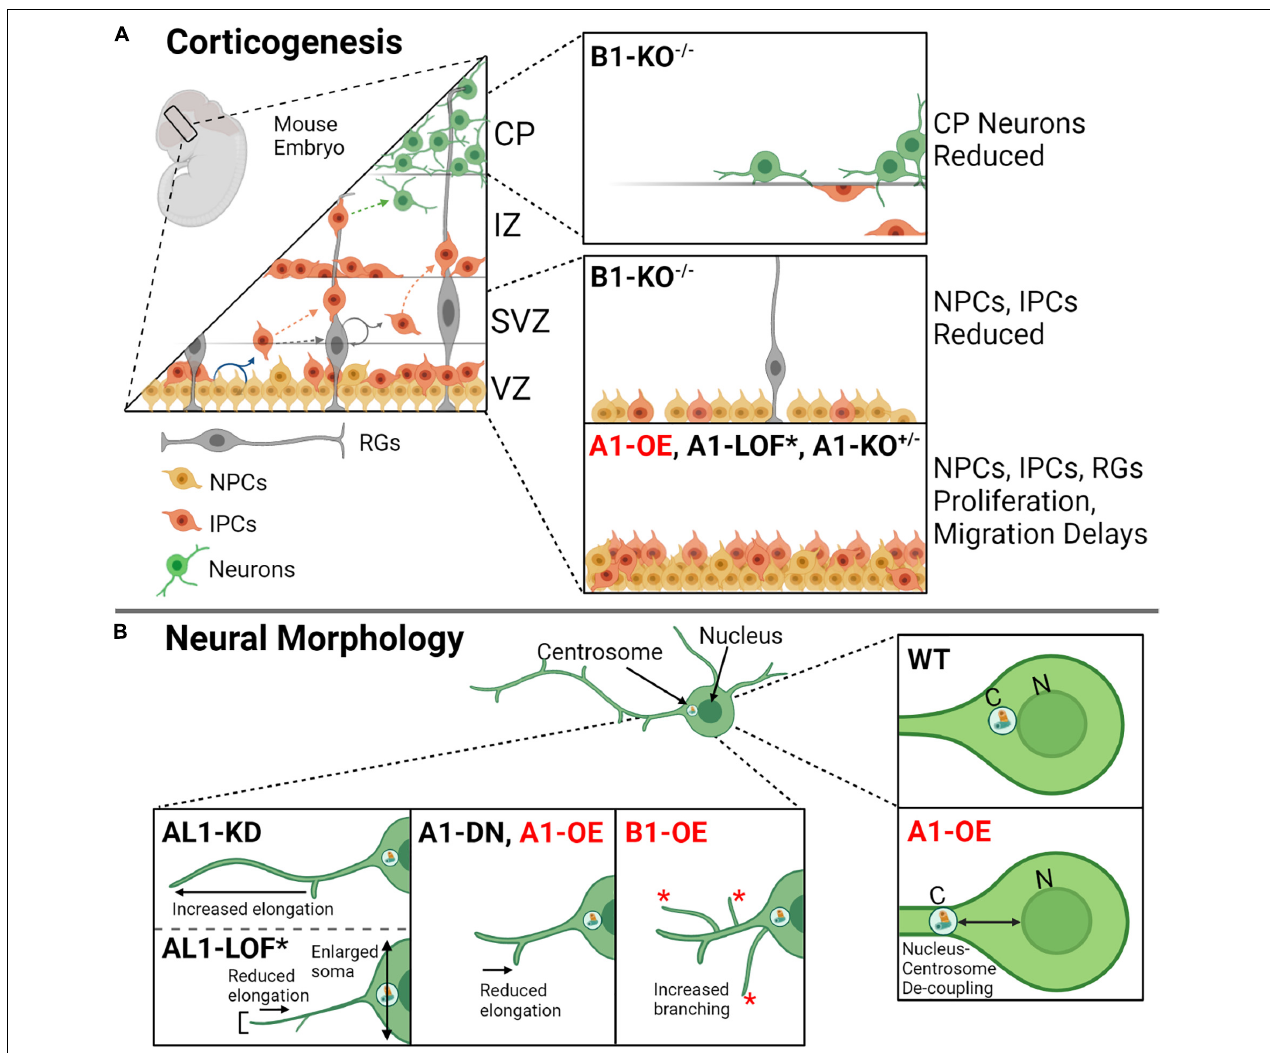
FIGURE 4 | Katanin function during corticogenesis and in neural morphology. (A) During mouse corticogenesis, the katanins regulate asymmetrical proliferation, cellular migration, and neuron development. Dysregulation of katanin subunit levels by heterozygous knockout (KO + / − ), homozygous knockout (KO – / – ), loss of function (LOF), and/or overexpression (OE) leads to disruptions at different cortical layers (VZ, ventricular zone; SVZ, subventricular zone; IZ, intermediate zone; CP, cortical plate; MZ, marginal zone). The affected cells include neural progenitor cells (NPCs), intermediate progenitor cells (IPCs), radial glia, and developed neurons. (B) Katanin A1, AL1, and B1 are involved in neural morphology, contributing to process elongation and branching. Knockdown of AL1 enhances process length (process elongation), while AL1 loss of function by means of a recessive mutation AL1 1H / 1H in mice (indicated by asterisk; see Figure 3 for this mutant) contributes to shorter and thinned axons, reduced process elongation, and enlarged soma. Dominant negative A1 leads to reduced process elongation as does A1 overexpression. Additionally, A1 overexpression increases the distance in nucleus–centrosome coupling in neurons. Lastly, B1 overexpression promotes increased branching in